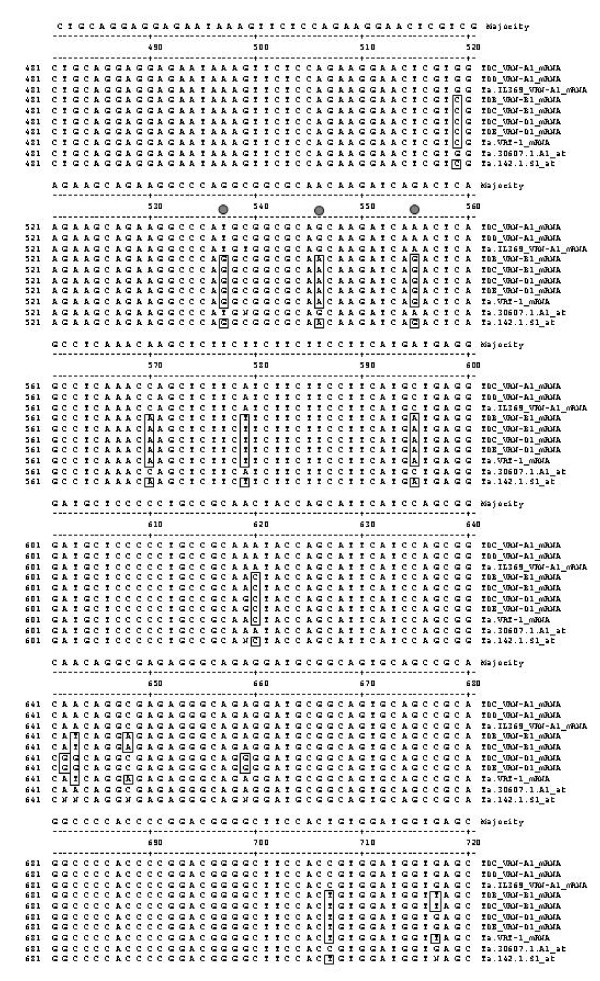
Comparison of Vrn-1 gene sequences from hexaploid wheat T. aestivum. Boxed letters indicate divergence from TDC Vrn-A1 mRNA sequence. Closed circles below the consensus sequence indicate SNPs covered by the probesets for Ta.30607.1.A1, Ta.142.1.S1_at.